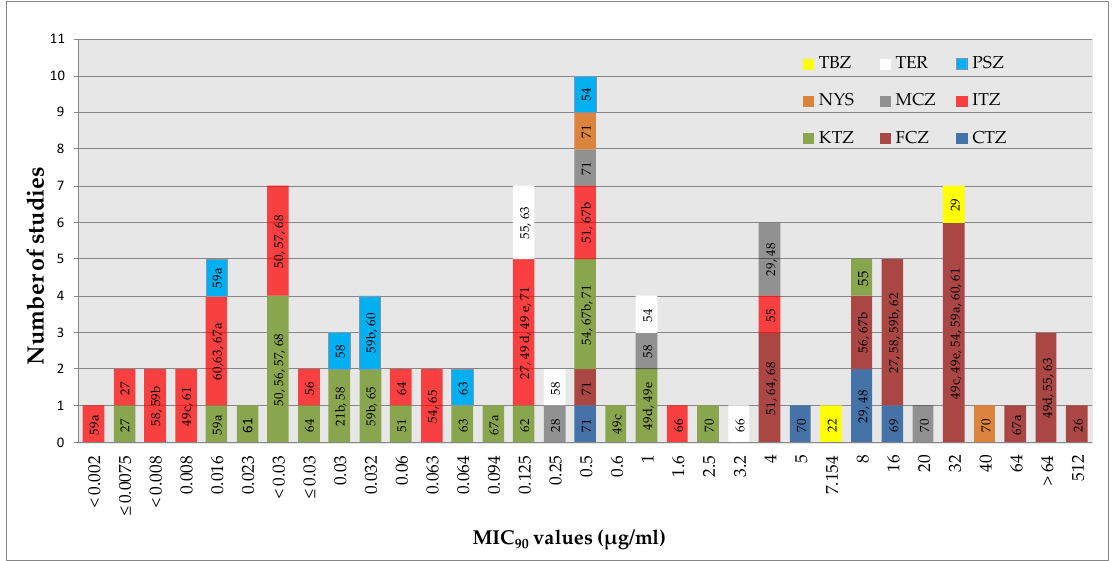
Figure 4. MIC 90 values obtained for different antifungal agents against M. pachydermatis and the number of studies that reported each value (MIC 90 is the MIC required to inhibit the growth of at least 90% of the isolates tested). References are inside the bars. a = MICs obtained with an E-test; b = MICs obtained with the BMD method; c, d, e = MICs obtained in Sabouraud Broth + Tween, Urea Christensen Broth + Tween, and Dixon broth, respectively. Due to space limitations, the values refer to the overall isolates tested in each study; eventual results regarding specific subgroups of strains within a study (e.g., coming from animals with/without lesions) are not included. KTZ = ketoconazole; MCZ = miconazole; CTZ = clotrimazole; ECZ = econazole; ITZ = itraconazole; FCZ = fluconazole; PSZ = posaconazole; NYS = nystatin; TER = terbinafine; TBZ = thiabendazole.